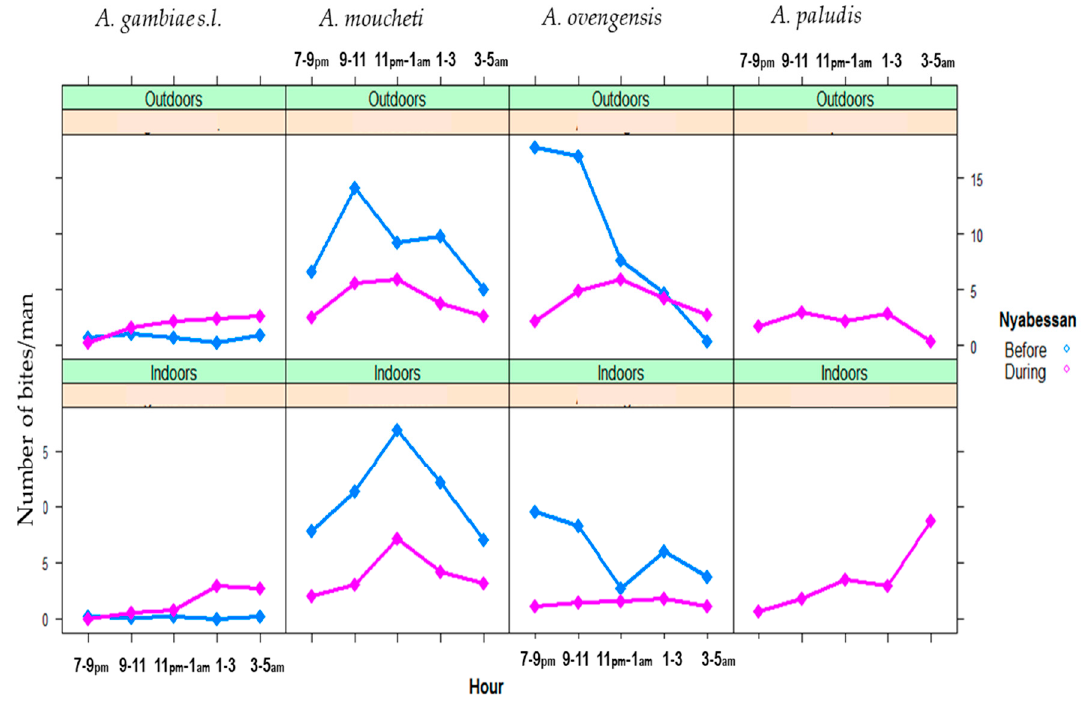
Figure 5. Patterns of the hourly biting curves for four major malaria vector species in Nyabessan, indoors and outdoors before and during dam construction.